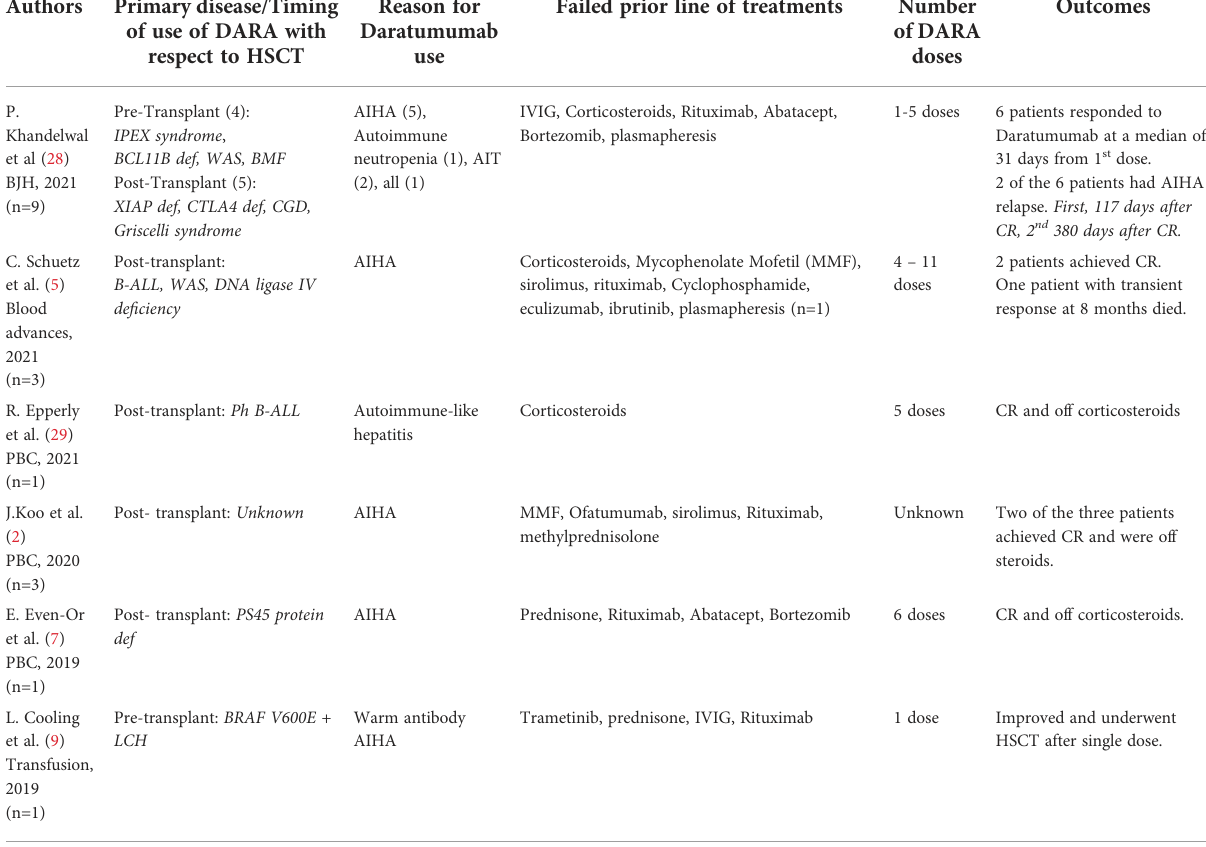
TABLE 1 Summary of published literature in the last 3 years using DARA in antibody mediated disorders in pre and post-transplant setting.